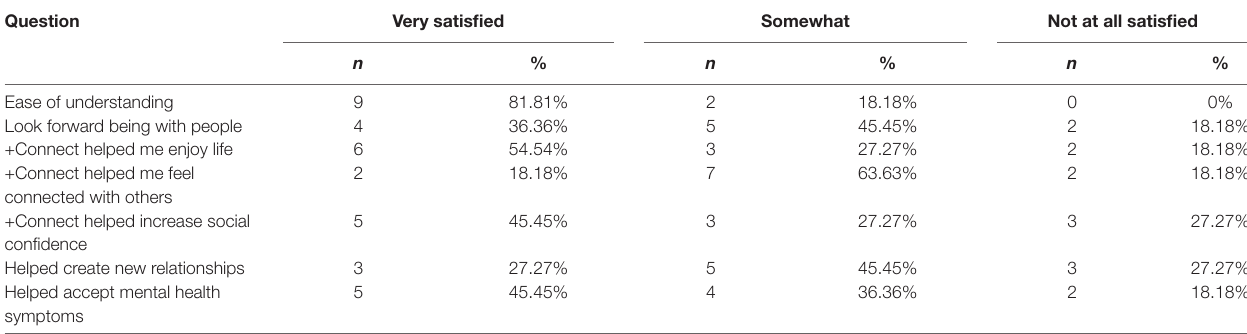
TABLE 4 | Post-intervention outcome satisfaction ratings of the +Connect for the student